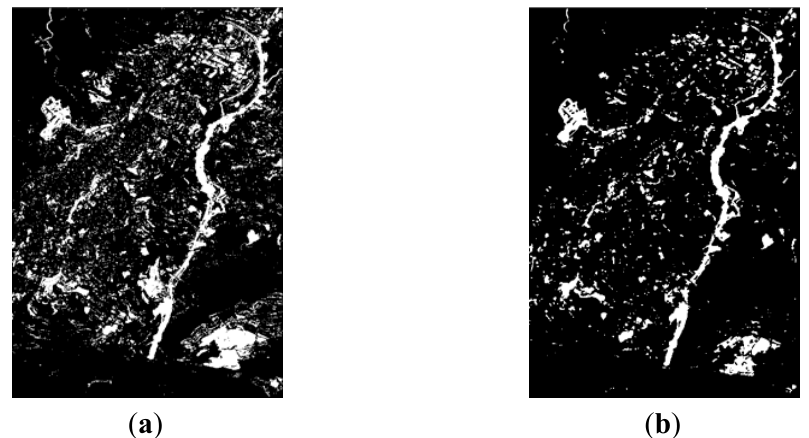
Figure 9. Level 1. Change Detection documents ( λ method; ( b ) Multiplicative